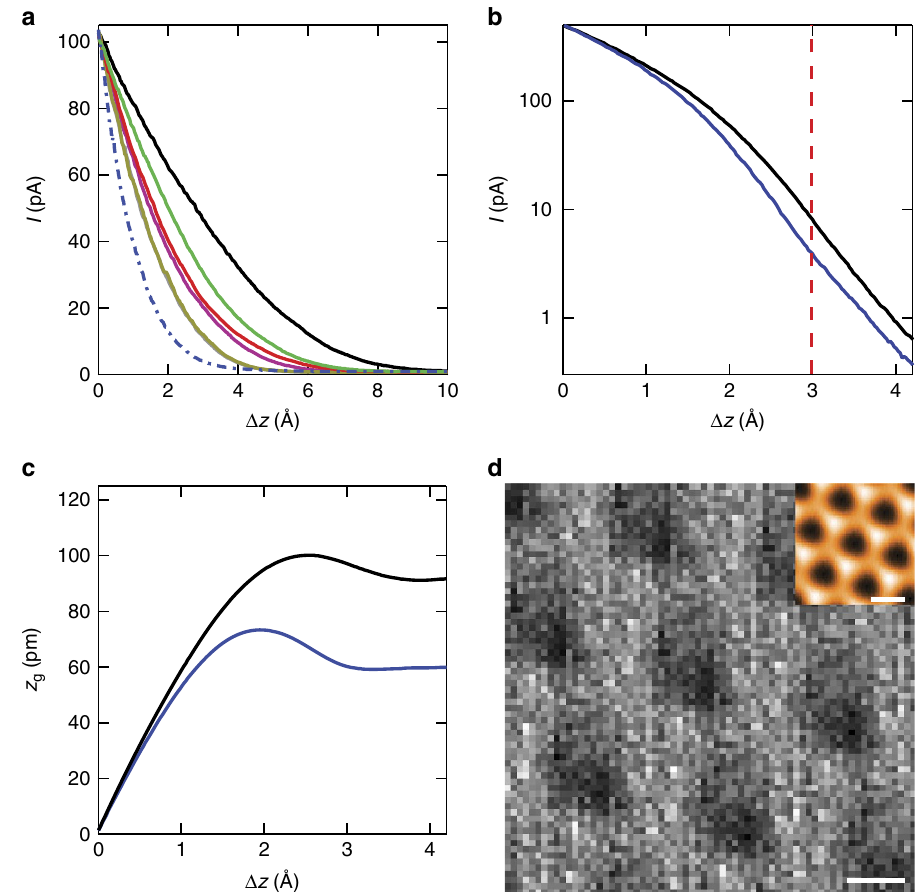
Figure 2 | Tunnelling current as a function of tip-sample separation. ( a ) Measurement of the tunnel current I versus tip retraction distance D z for nearly-aligned graphene on hBN, starting with the tip in close proximity to the sample. The dot-dashed blue curve is taken on graphene on SiO 2 for reference, and exhibits the anticipated exponential decay. The remaining curves, from gold to black, represent decreasing sample bias (that is, moving the tip closer to the surface), from 1 to 0.05V. The decay is initially parabolic, and the crossover point to exponential decay grows to larger D z as the sample bias is lowered. ( b ) Similar decay measurement plotted on a log scale on a CB (blue) and CN/AA (black) region. The transition from parabolic to linear occurs at D z of about 2Å. ( c ) Out-of-plane graphene movement relative to the hBN ( z g ) as a function of tip separation D z . As the tip is initially retracted, the graphene moves with it, lifting away from the hBN. At just over 2Å, a maximum pulling distance is reached, and on further tip retraction the graphene slowly relaxes back towards the hBN. ( d ) Spatial map of the tunnelling current (dark is low and bright is high). The data are taken from the same set as in ( b ), at D z ¼ 3Å. The inset displays the simultaneously acquired topography. The tunnelling current is smaller in the moire´ centres than along the boundaries, suggesting a spatial modulation in the ability of the tip to pull the graphene off the hBN substrate. The maps have been spatially-averaged (see main text). Note that a similar pattern is exhibited at all D z , as the blue curve is always below the black in ( b ). The scale bar is 5nm for the main panel and 10nm for the